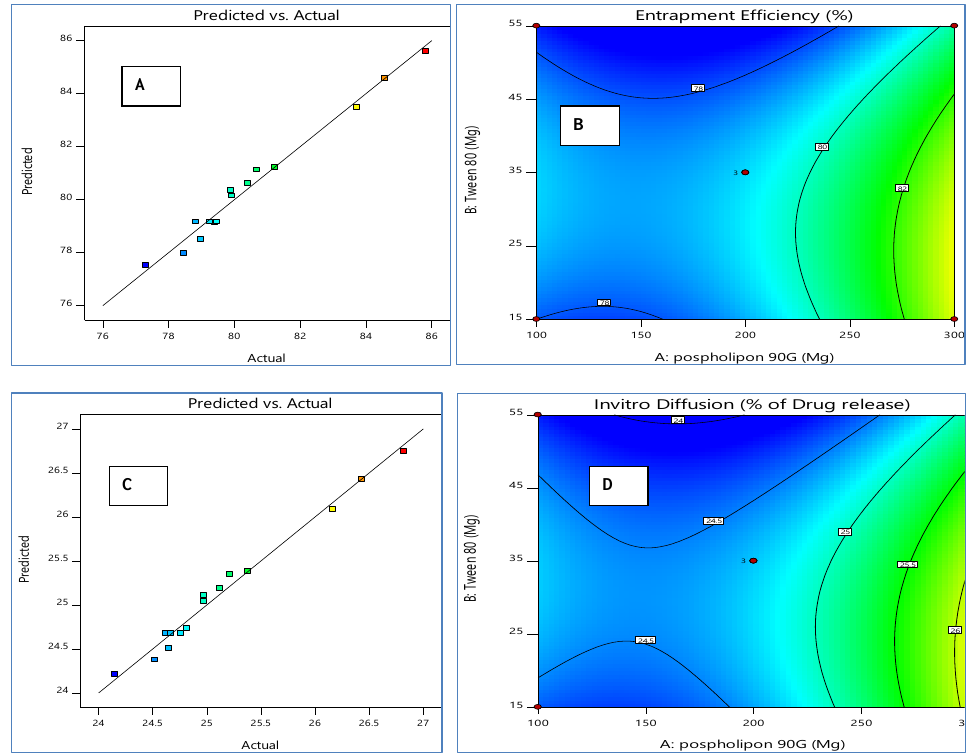
Figure 2. Three-dimensional response surface plot showing the effect of independent variables such as phospholipid concentration (mg) (X1), Tween 80 (mL) (X2), and sonication time (min) (X3) on ( A ) % entrapment efficiency (Y1) and ( B ) in vitro diffusion at 6 h (Y2).